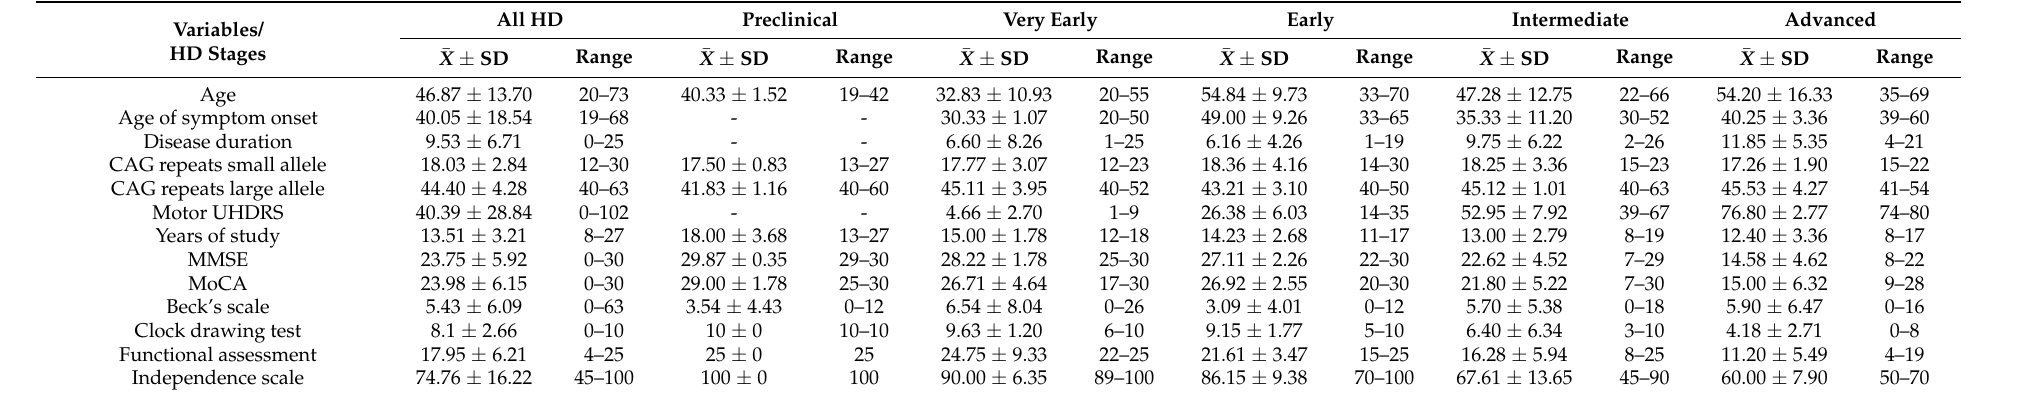
Table 1. Characteristics of the study group divided into HD